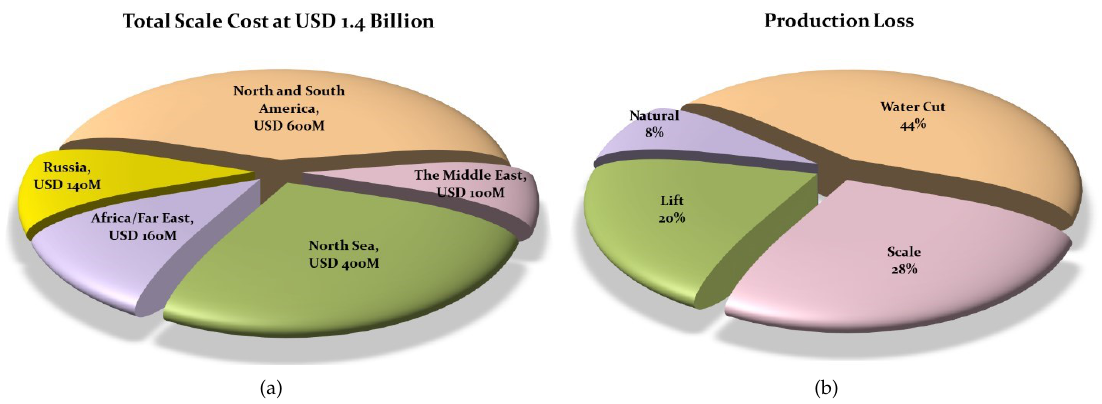
Figure 1. ( a ) World-wide cost of scale treatment and ( b ) production loss due to different processes in the North Sea (modified after